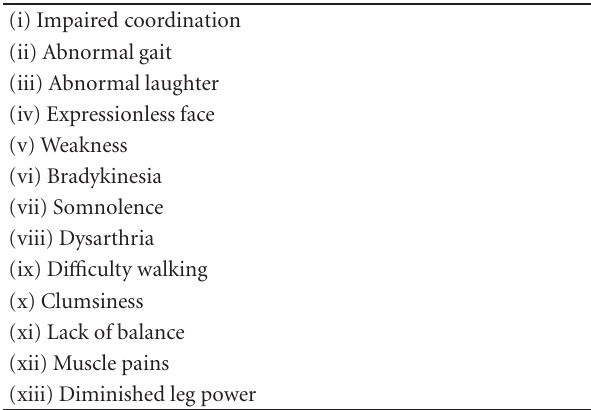
Table 2: Signs of manganese